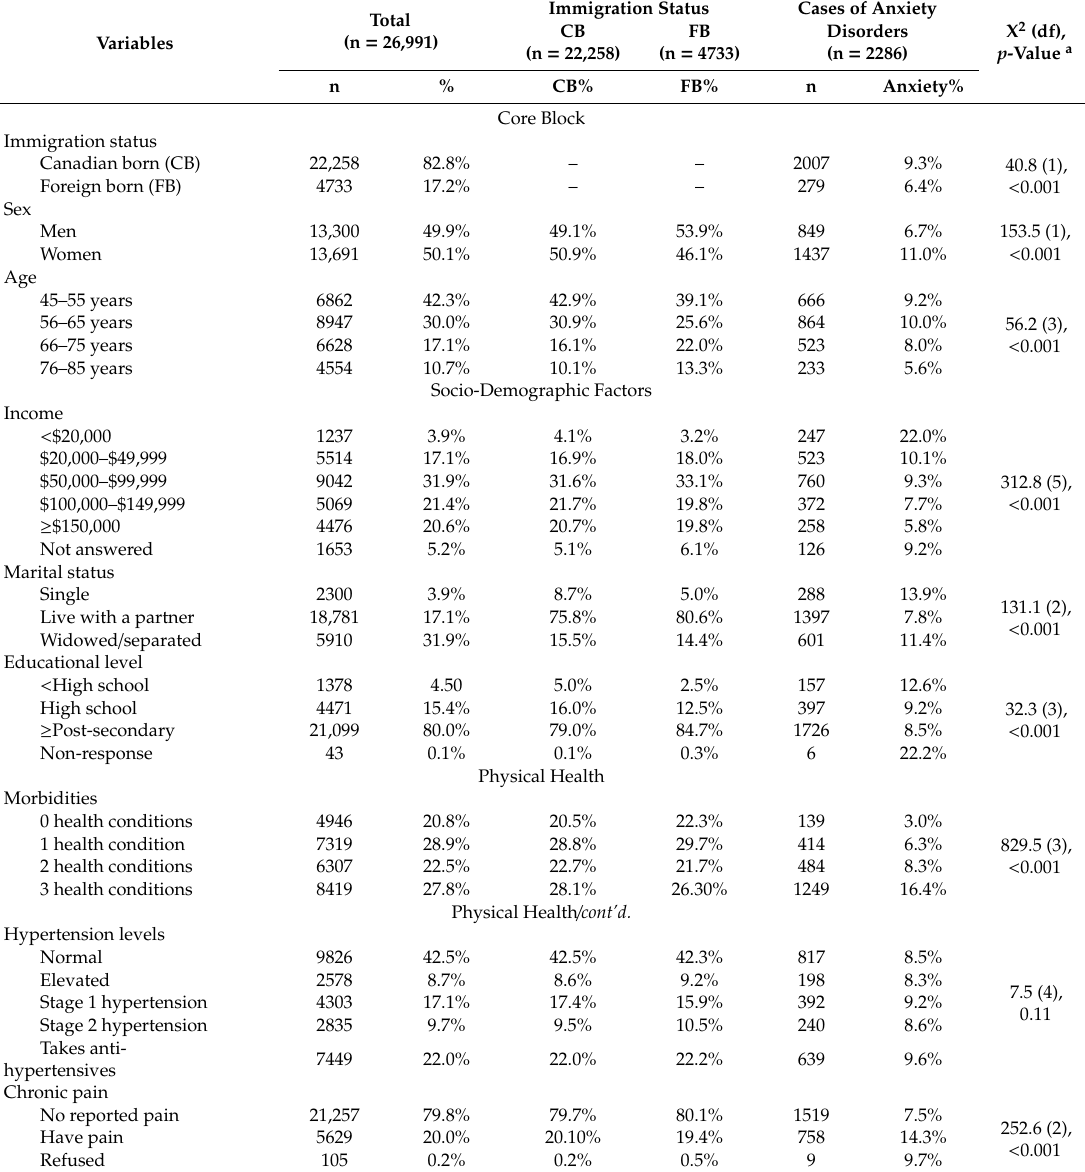
Table 1. Prevalence estimates of immigration status and anxiety diagnosis by sample